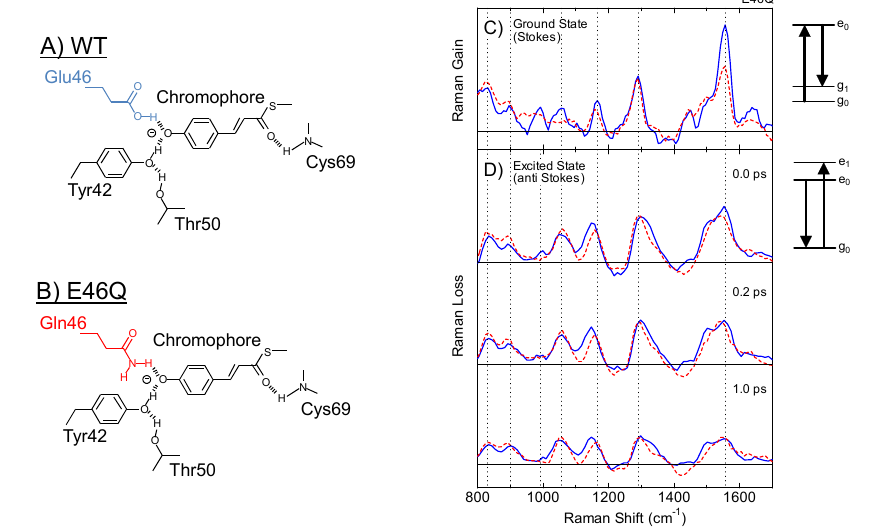
Fig. 1. Schematic depictions of the chromophore with its surrounding hydrogen-bonding network for (A)WT PYP and (B) E46Q mutant. (C) Stimulated Raman signals on the Stokes side of the initial ground state. (D) Femtosecond stimulated Raman signals on the anti-Stokes side measured at selected delay times after photoexcitation. Diagrams depicted at the right-hand side of the figure are the corresponding Raman processes, where g 0 (g 1 ) and e 0 (e 1 ) are vibrational ground (excited) states belonging to the electronic ground and excited states,